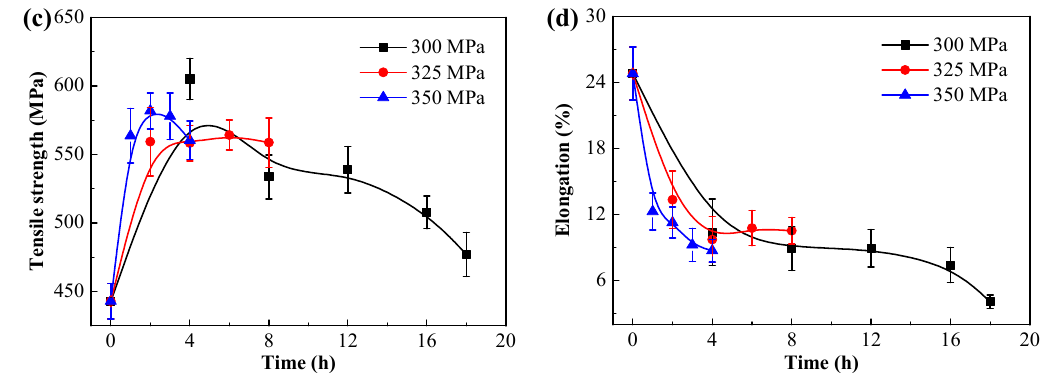
Figure 4. Mechanical properties evolutions of AA7050 during creep aging tensile tests under 165 °C and different stress levels: ( a ) hardness; ( b ) yield strength; ( c ) tensile strength; and, ( d ) elongation.